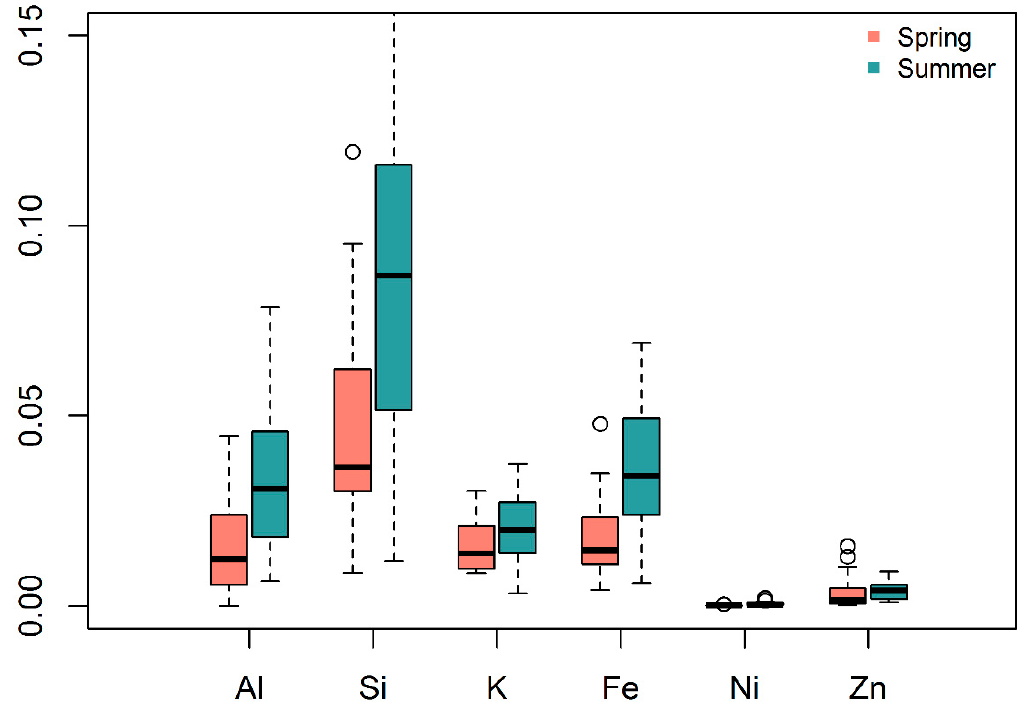
Figure 3. Normalized concentrations of elements ( µ g/m 3 of elements normalized by µ g/m 3 of PM 2.5 ) during spring and summer seasons, 2014.